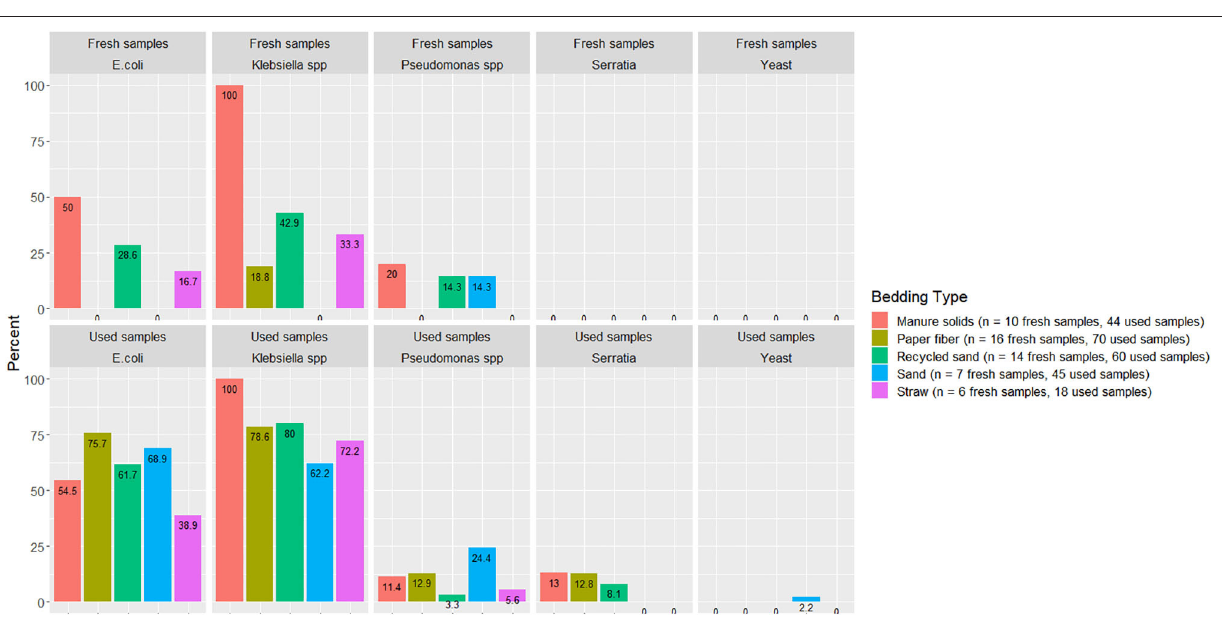
FIGURE 3 | Proportion of used or fresh bedding samples with detectable organisms of mastitis importance. Fresh and used bedding samples collected from July 2018 to July 2019 from five conveniently selected New York dairy herds using one of five bedding materials in lactating pens. One fresh bedding sample and three to five used bedding samples were collected monthly following an SOP at each visit (unless there was no bedding available due to lack of supply or equipment malfunction on the follow-up